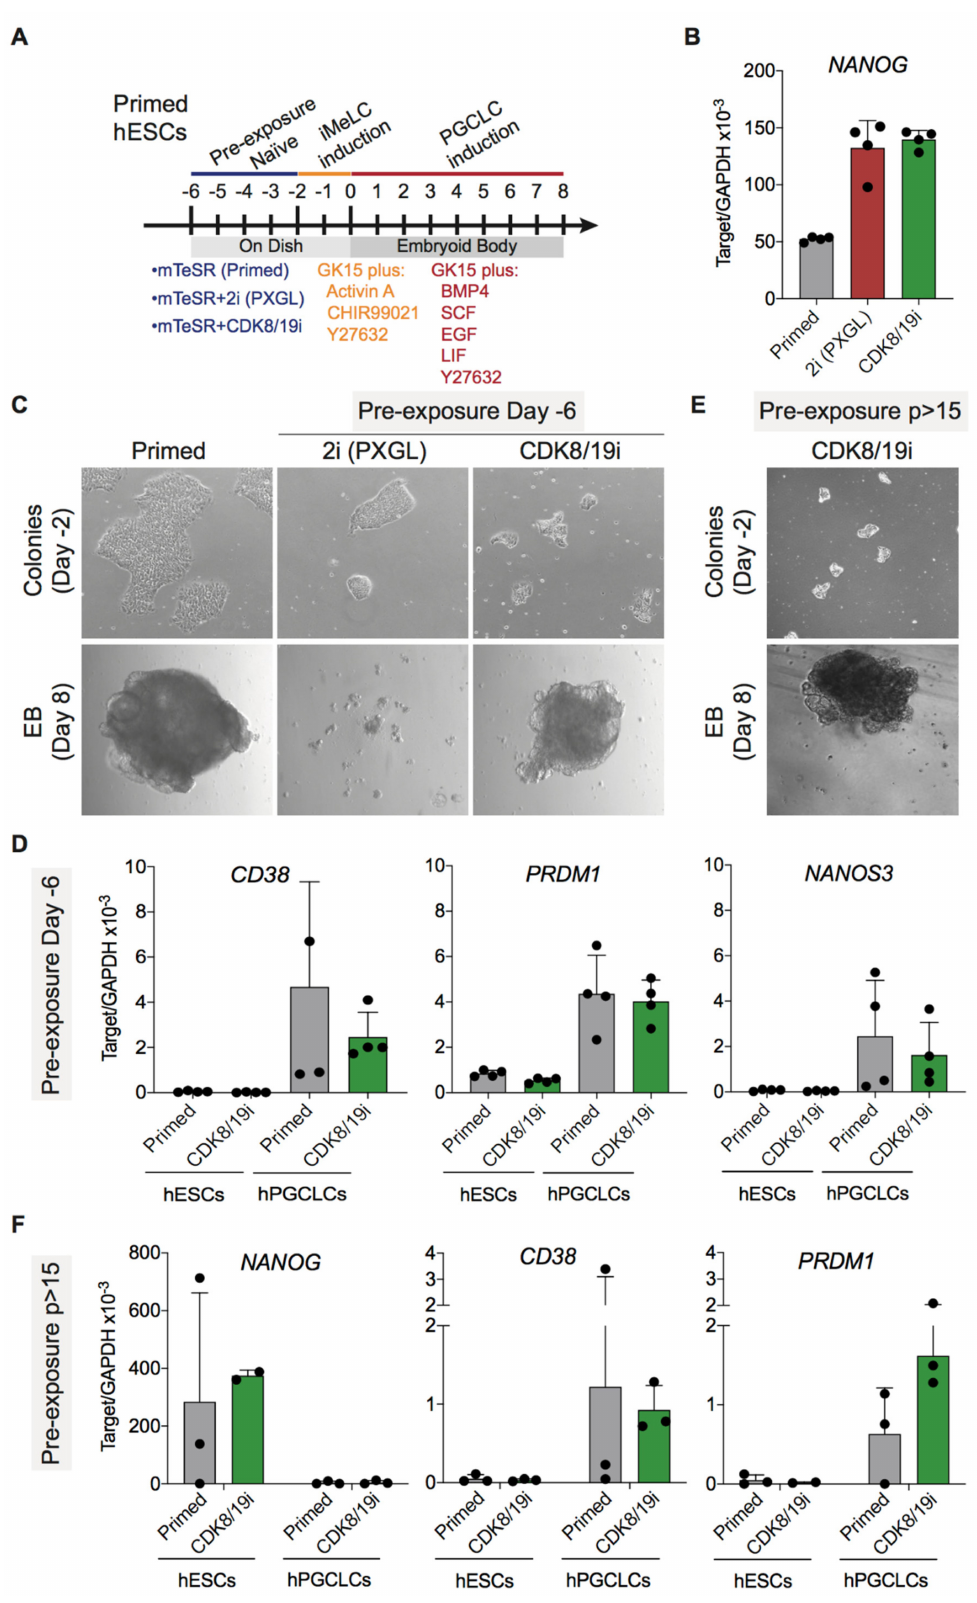
Figure 3. CDK8/19i-naïve hPSCs can differentiate into primordial germ cell-like cells (hPGCLCs). ( A ) Experimental scheme for assessing PGC differentiation of primed, 2i (PXGL) and CDK8/19i-naïve hESCs. iMeLCs: induced mesoderm-like